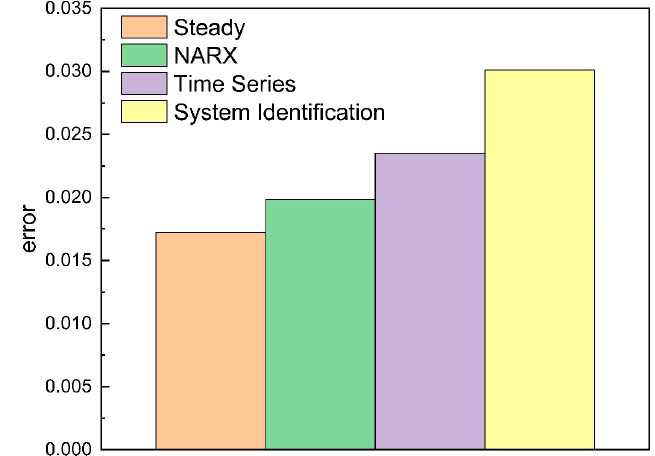
Figure 16. Overall deviation.